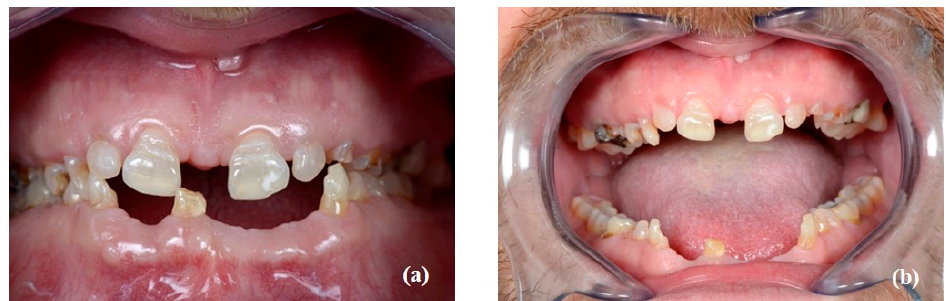
Figure 3. Intraoral examination: frontal view ( a ) dental arches in occlusion; ( b ) arches in full opening.